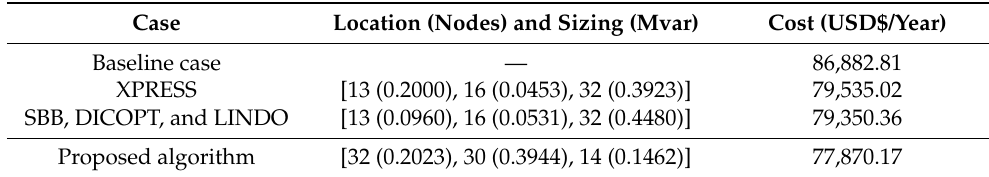
Table 6. Best results obtained for the baseline case; the XPRESS, SBB, DICOPT, and LINDO optimizers; and the proposed